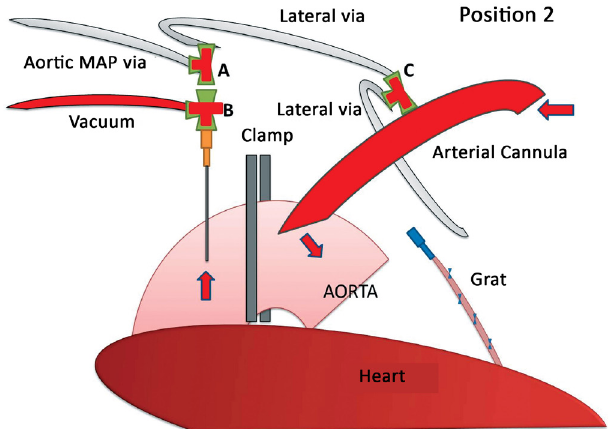
Fig. 2 - It should be used during the anoxia time during anastomosis, both distal and proximal, in which the point “B” is closed to the side via and opened to the aspirator which is used according to the need